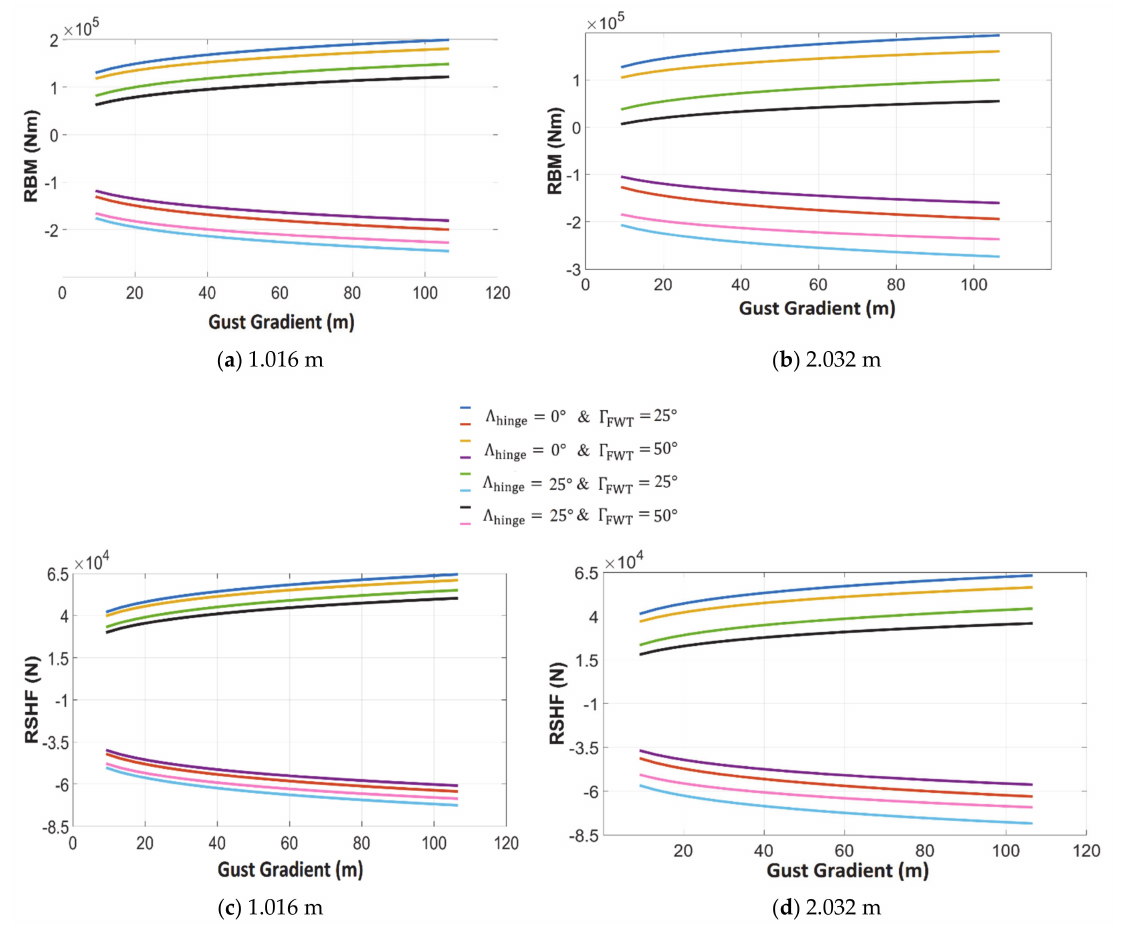
Figure 8. Variations in RBM and RSHF for 1.016 and 2.032 m outboard segment